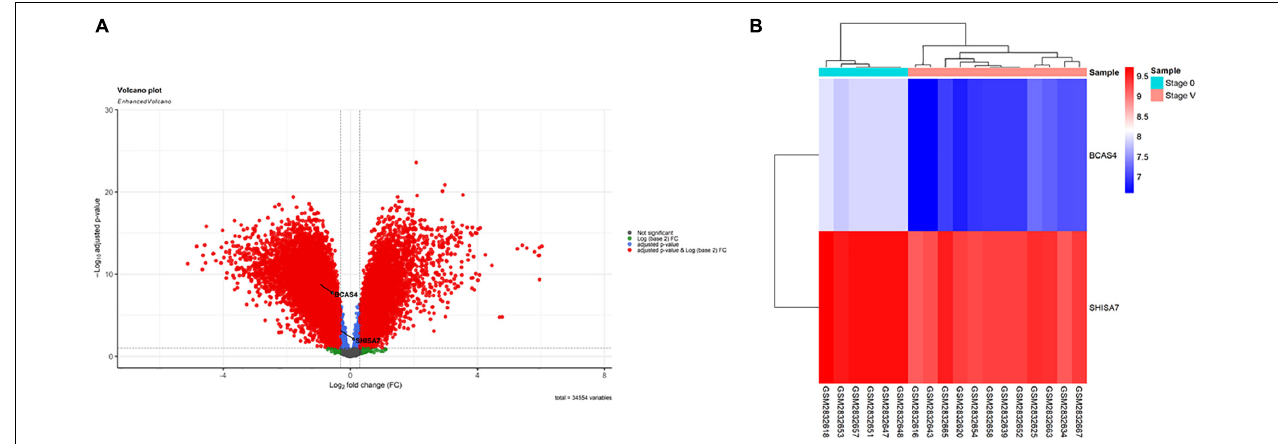
FIGURE 1 | Differentially expressed mRNAs between brain samples of Alzheimer’s disease (AD) patients in Braak stage V and control (CTL) samples. (A) Volcano plot for the DEGs. The DEGs were screened based on a | (log2FC) | > 0.3 and an adjusted P -value < 0.01. (B) Heatmap for BCAS4 and SHISA7 genes. High expressed genes are shown in red, while those expressed at low levels are